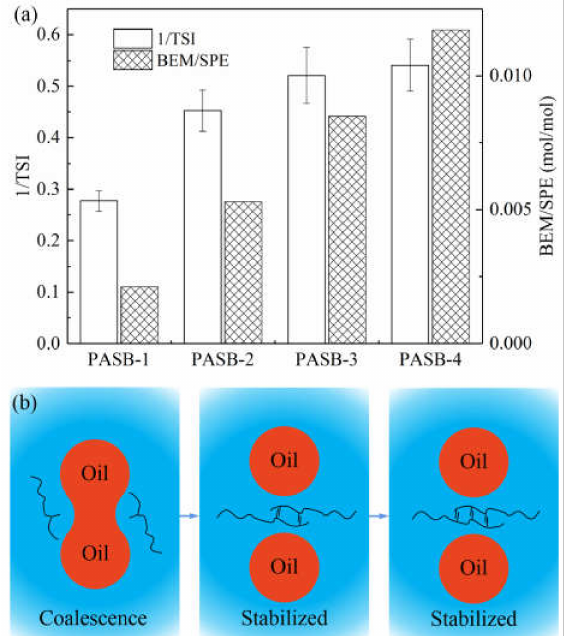
Figure 7. The relationship between emulsion stability and polymer intermolecular association. ( a ) Correspondence between 1/ TSI and BEM/SPE ratio. ( b ) A schematic diagram of the inter- molecular association of polymers preventing the coalescence of oil droplets. When PASBs have effectively prevented the occurrence of flocculation and coalescence, the stability is difficult to be further